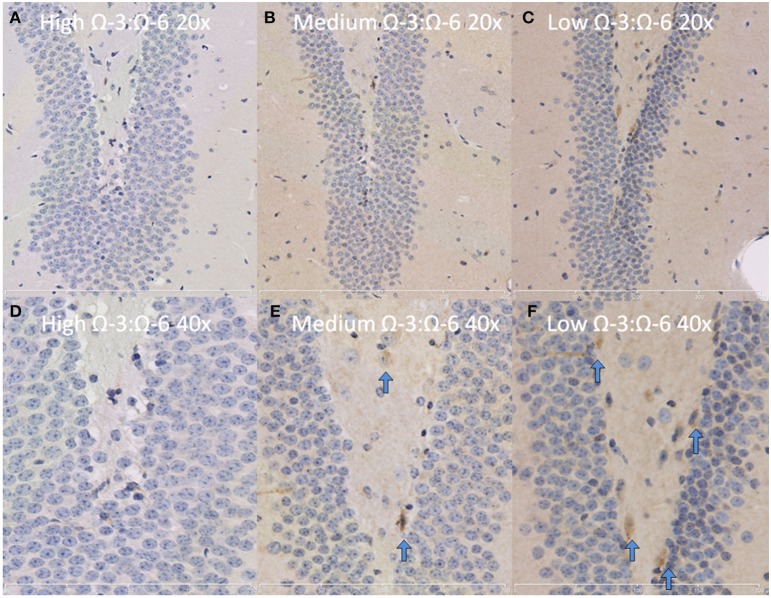
Representative images of TNF-α expression in the dentate gyrus. Representative images of the hippocampus centered on the dentate gyrus to demonstrate expression of TNF-α positive cells at 20× magnification in (A) High Ω-3:Ω-6 mice, (B) medium Ω-3:Ω-6 mice, (C) low Ω-3:Ω-6 mice and at 40× magnification in (D–F), respectively. Arrows signify relevant stained cells.